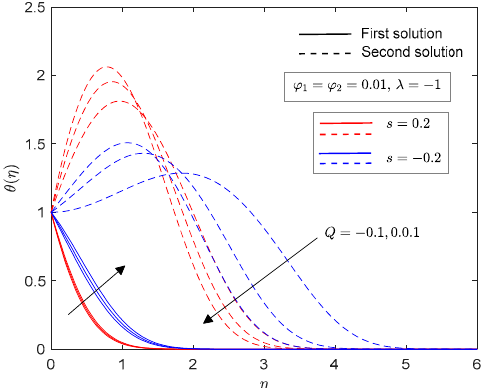
Figure 9. Impact of heat source/sink on θ ( η ) . Figure 9 . Impact of heat source/sink on